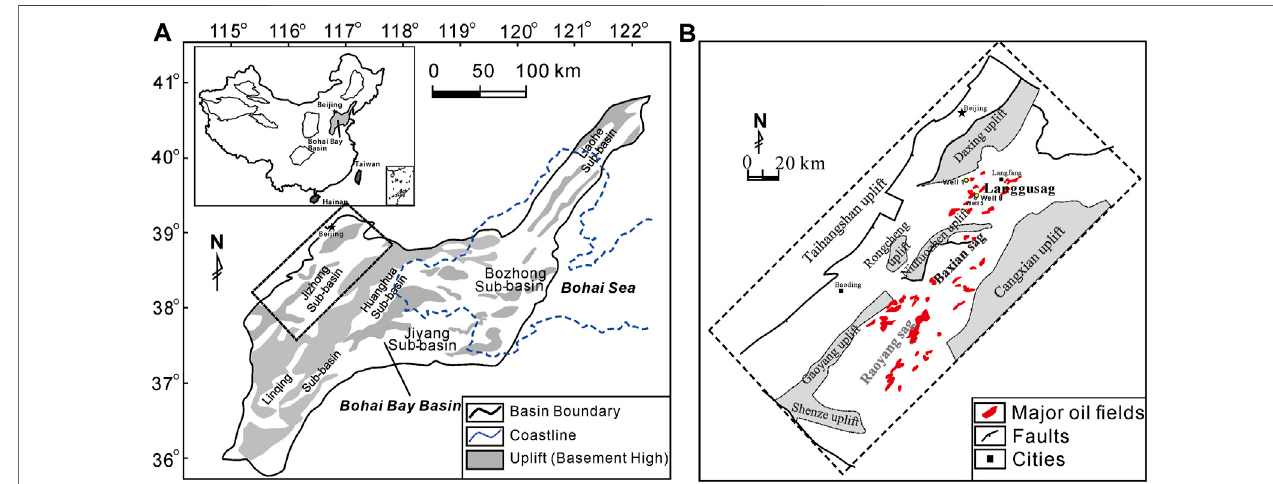
FIGURE 1 | (A) Sub-basins of the Bohai Bay basin (sub-basin classi fi cation from Allen et al., 1997). (B) Location and structural elements of the Jizhong subbasin. Wells with available core samples were marked in yellow in the Langgu sag.